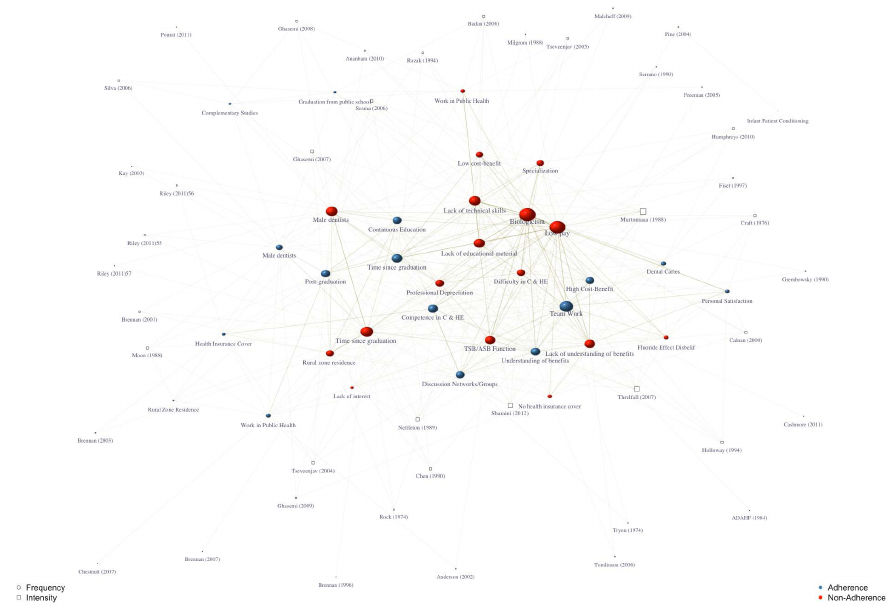
Figure 4. Factors that drive dentists towards or away from performing preventive measures. Graph theory-based figure showing the relation among qualitative studies and surveys included in the metasummary model. Squares represent the individual studies included, and circles the emerging factors. Size of each individual marking indicates its effect size (ES) in the model; larger markings being more recurrent. Studies presenting lower intensity ES (prevalence) appear further from the center, while studies with higher intensity ES closer to the center of the figure.